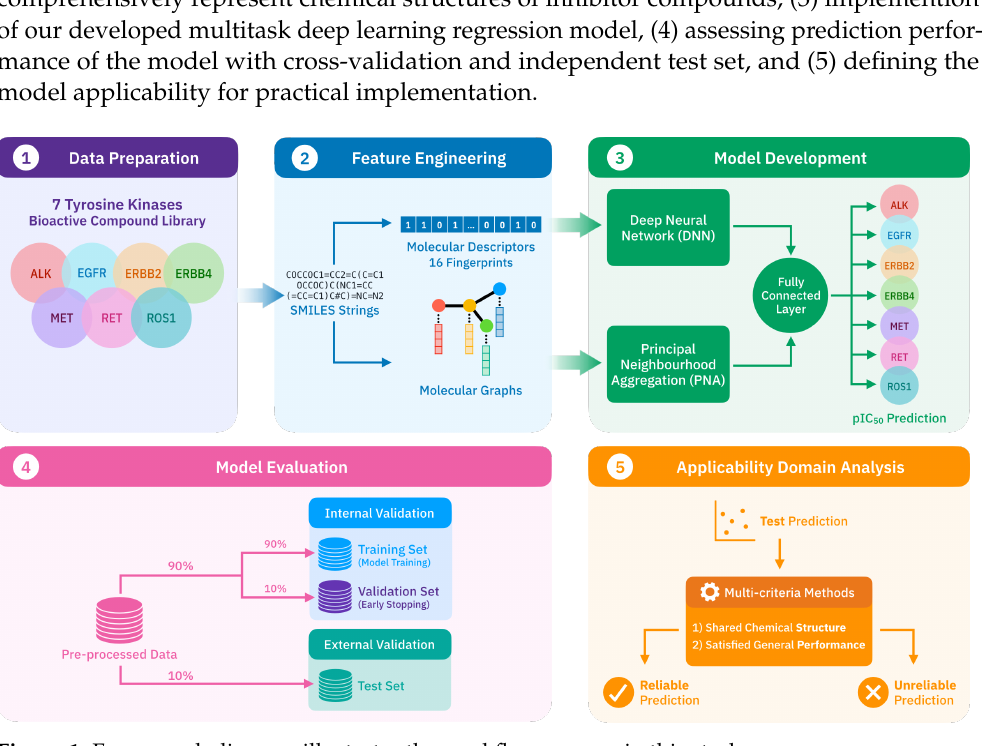
Figure 1. Framework diagram illustrates the workflow process in this